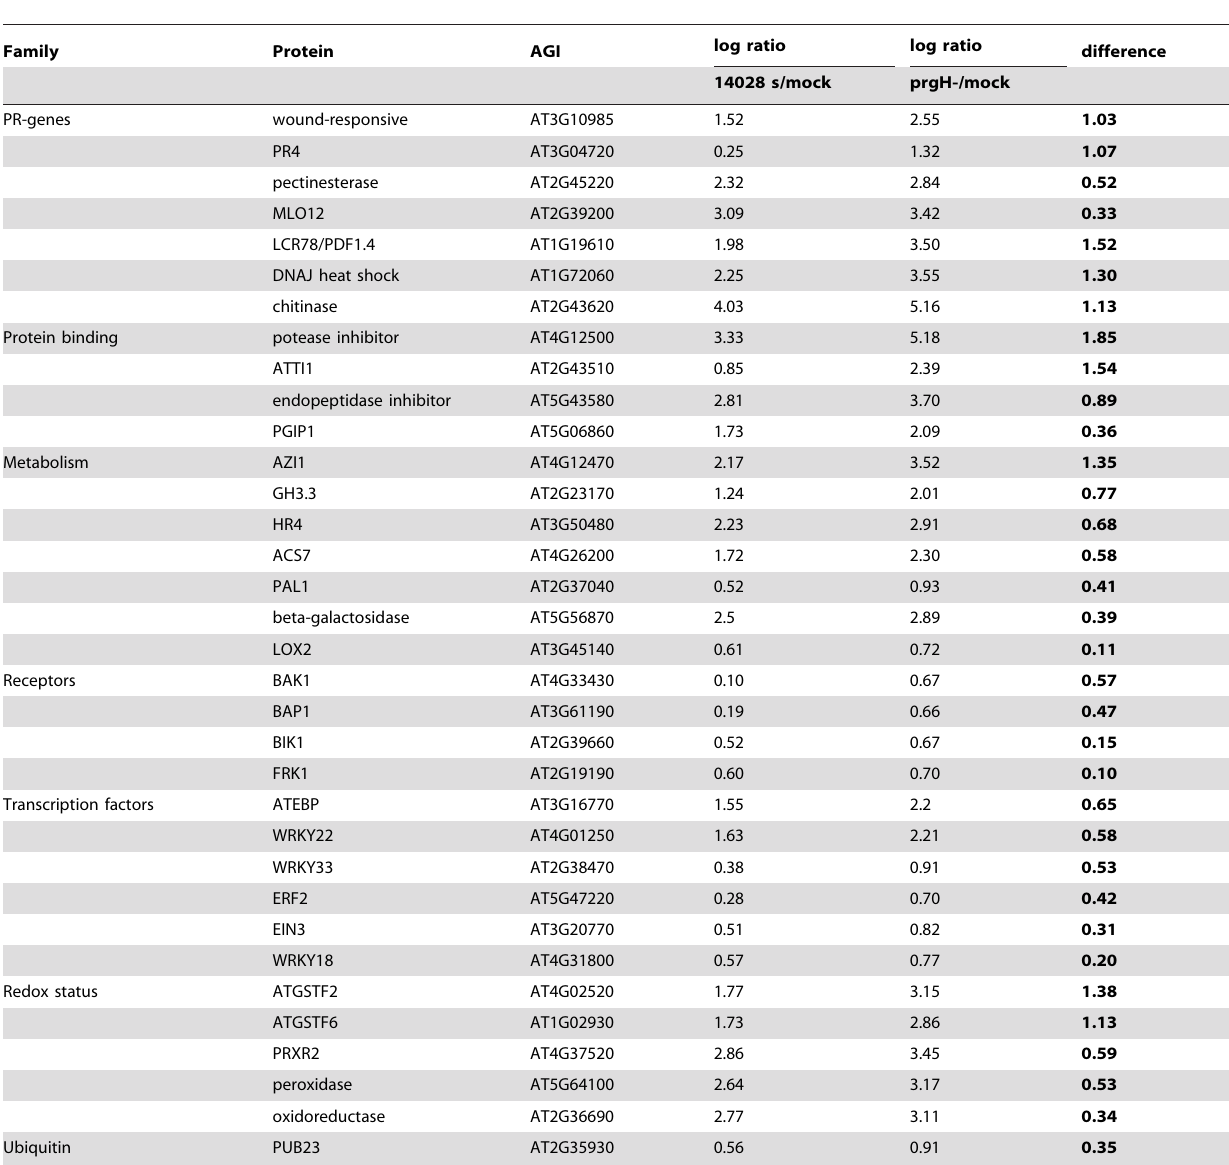
Table 1. Differences in Arabidopsis gene expression levels between plants infected with prgH 2 mutant or wild-type 14028 s Salmonella